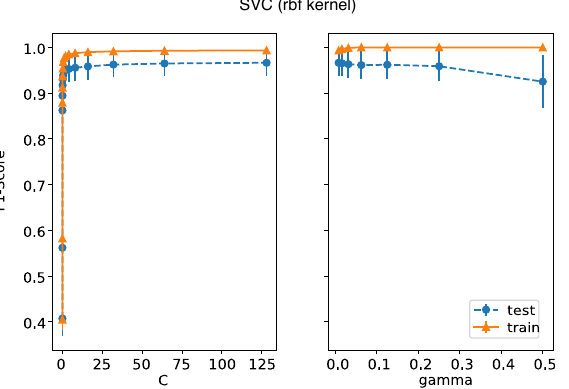
Figure 5. Mean performance of SVC (RBF kernel) models for respective evaluated hyperparameters with standard